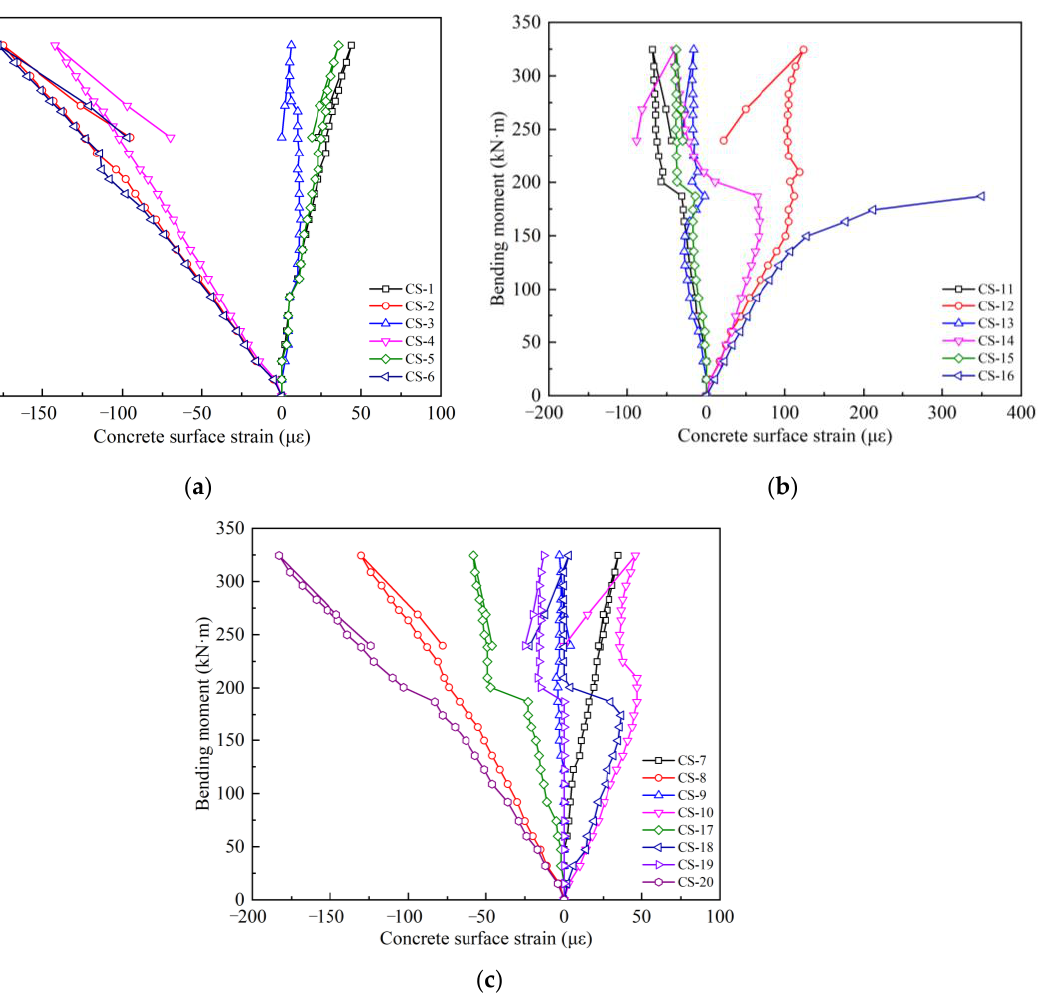
Figure 12. The bending moment – concrete strain relationship curves of 1/4 section: ( a ) monitoring points on top surface, ( b ) monitoring points on the bottom surface, ( c ) monitoring points on front and back surfaces.